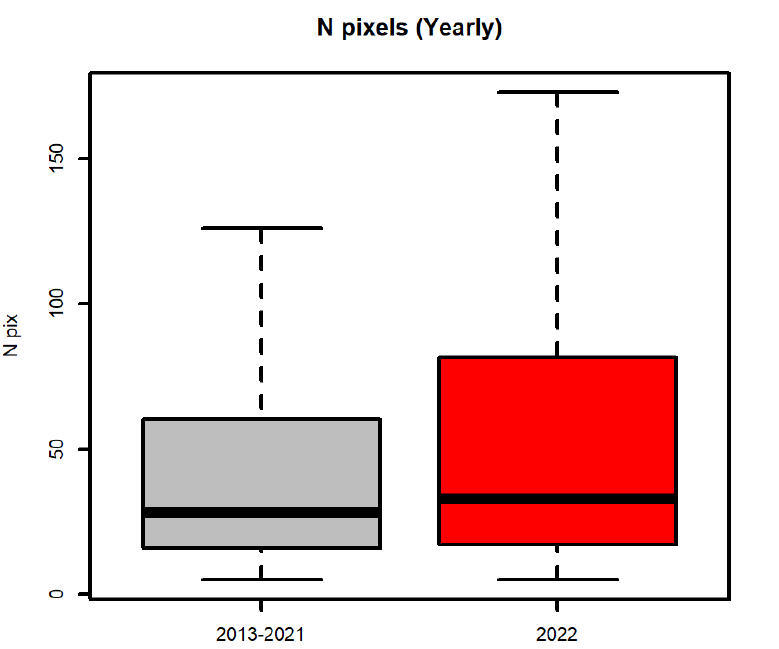
Figure 8. Estimated area (in number of pixels, where each pixel is equivalent to 1 km × 1 km) for the total set of cases of hail swaths estimated with the 20 kg/m 2 VIL threshold, for 2013–2021 (grey box) and 2022 (red box).